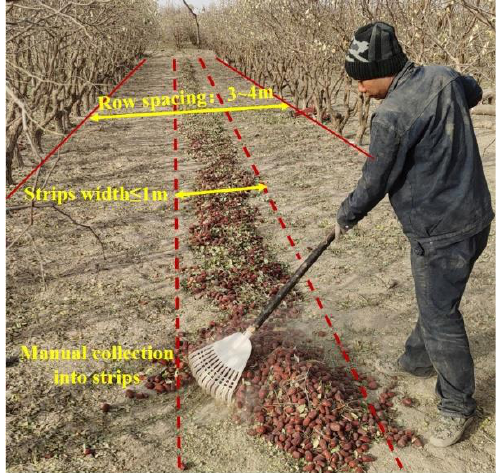
Figure 1. Manual strip collection — MCS.